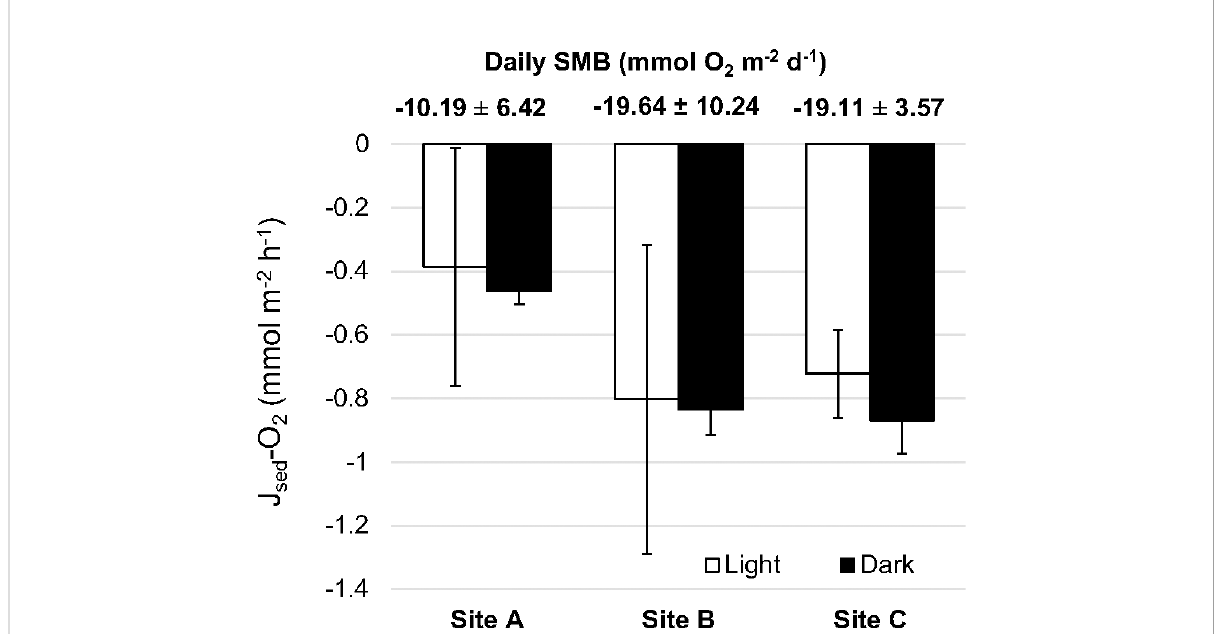
FIGURE 4 Sediment metabolic fl uxes of oxygen measured in light (white columns) and dark (black columns) conditions. Bars are mean ± SEM. Numbers above indicate the daily sediment metabolic balance (SMB) (mean ± SD) for each